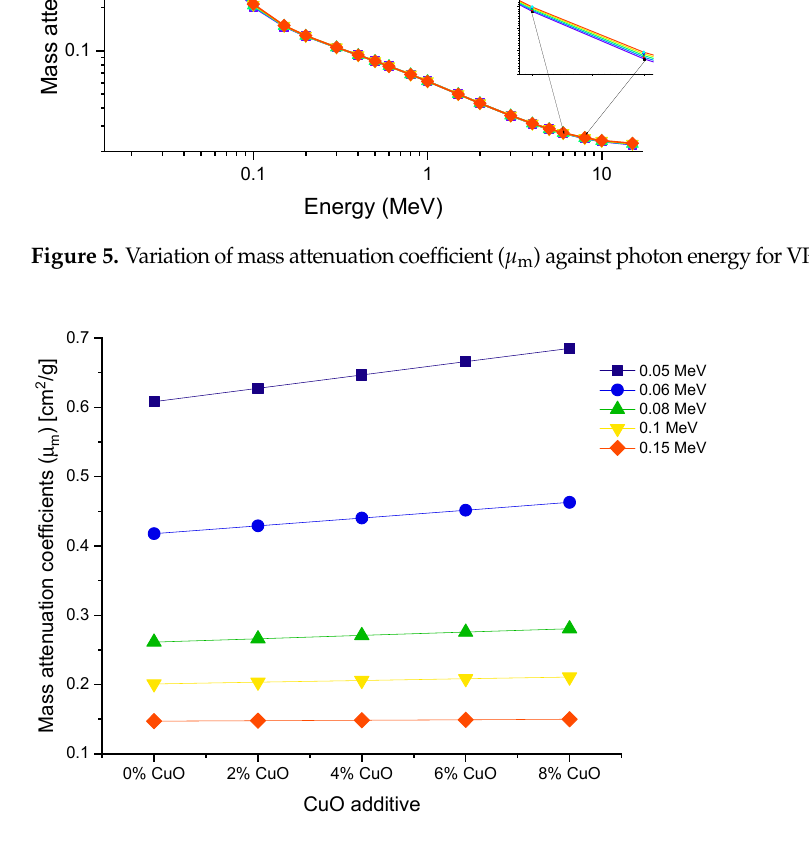
Figure 6. Variation of mass attenuation coefficients as a function of increasing CuO reinforcement.